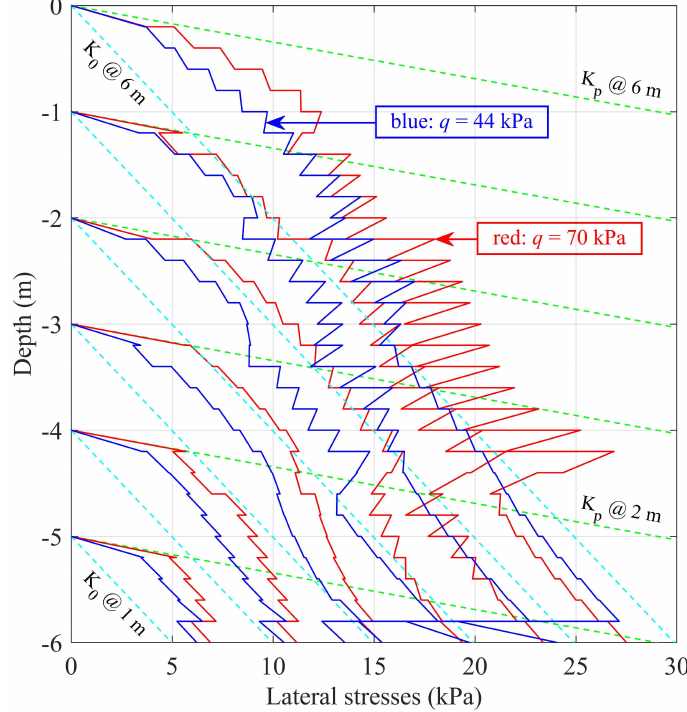
Figure 12. Incremental net compaction-induced stress corresponded to GRS mass construction using compaction procedure